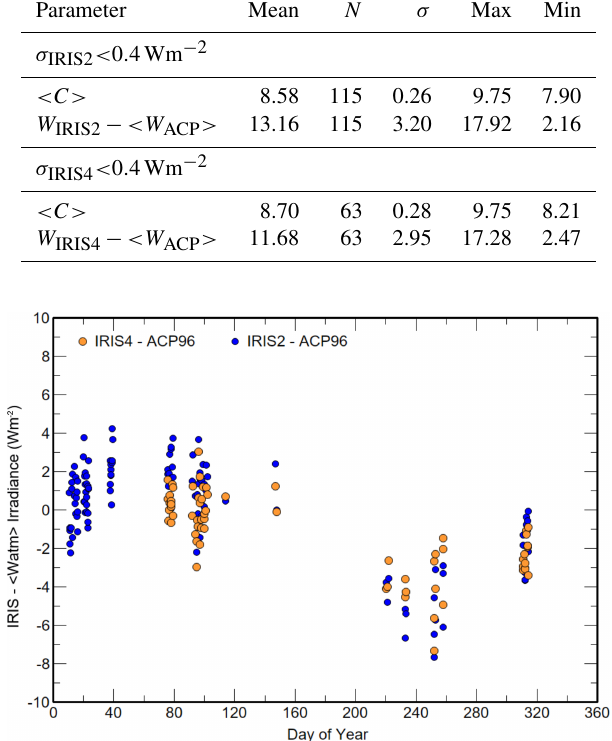
Figure 7. Daily mean irradiance differences ( W IRIS − <W atm > ) be- tween the mean IRIS ( W IRIS ) and linear LSQ-interpolated ACP96 ( <W atm > ), using the new equation with ε c = 0 . 0225, γ = 6 . 5 and τ = 0 .